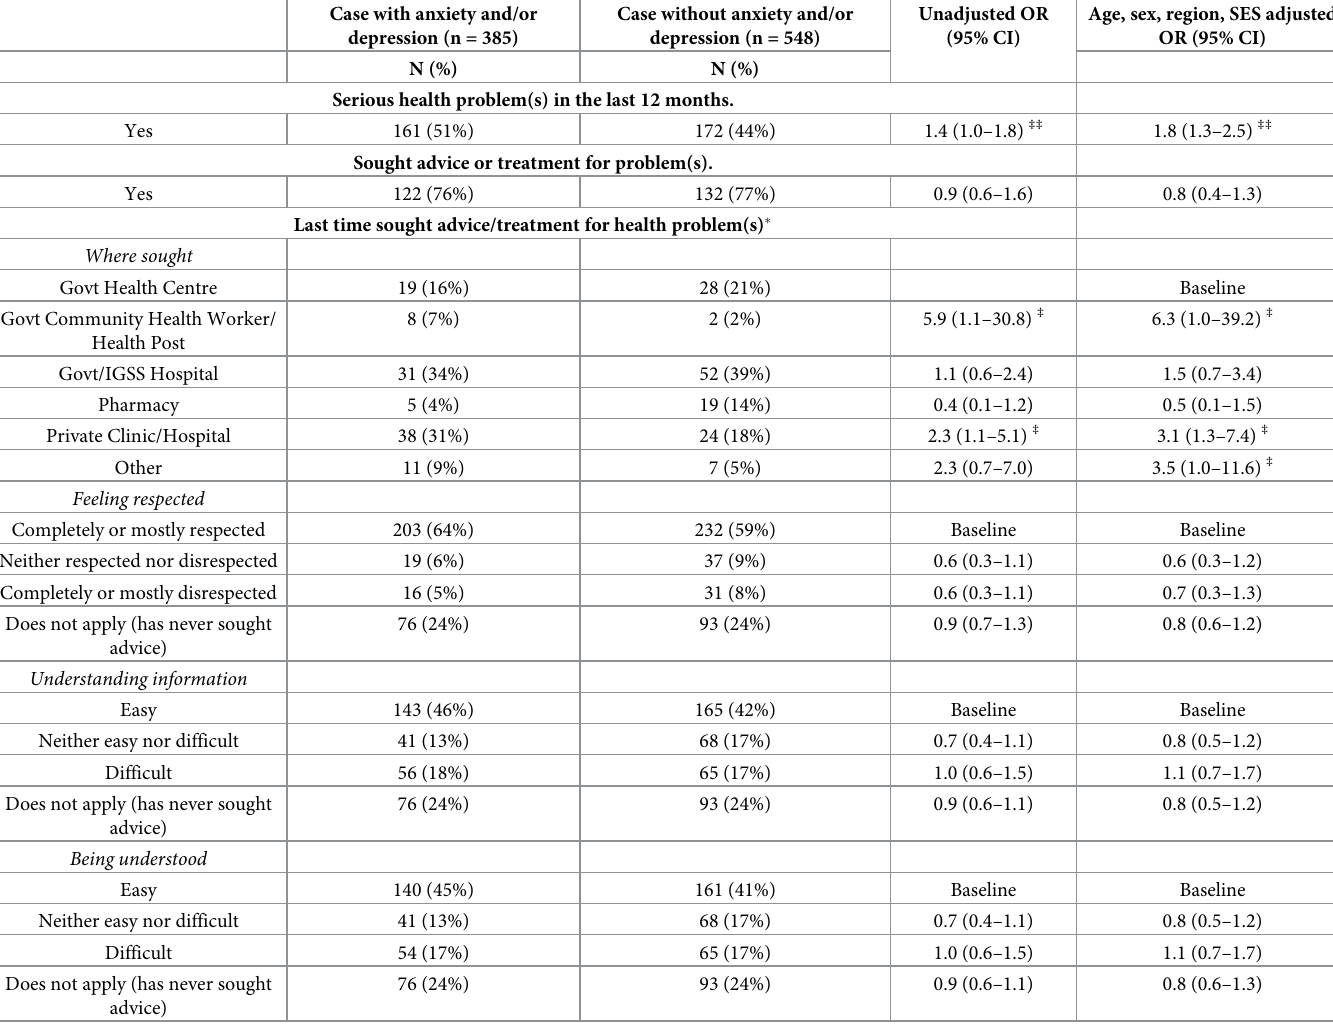
Table 6. Health advice/treatment, comparing cases with and without anxiety and/or